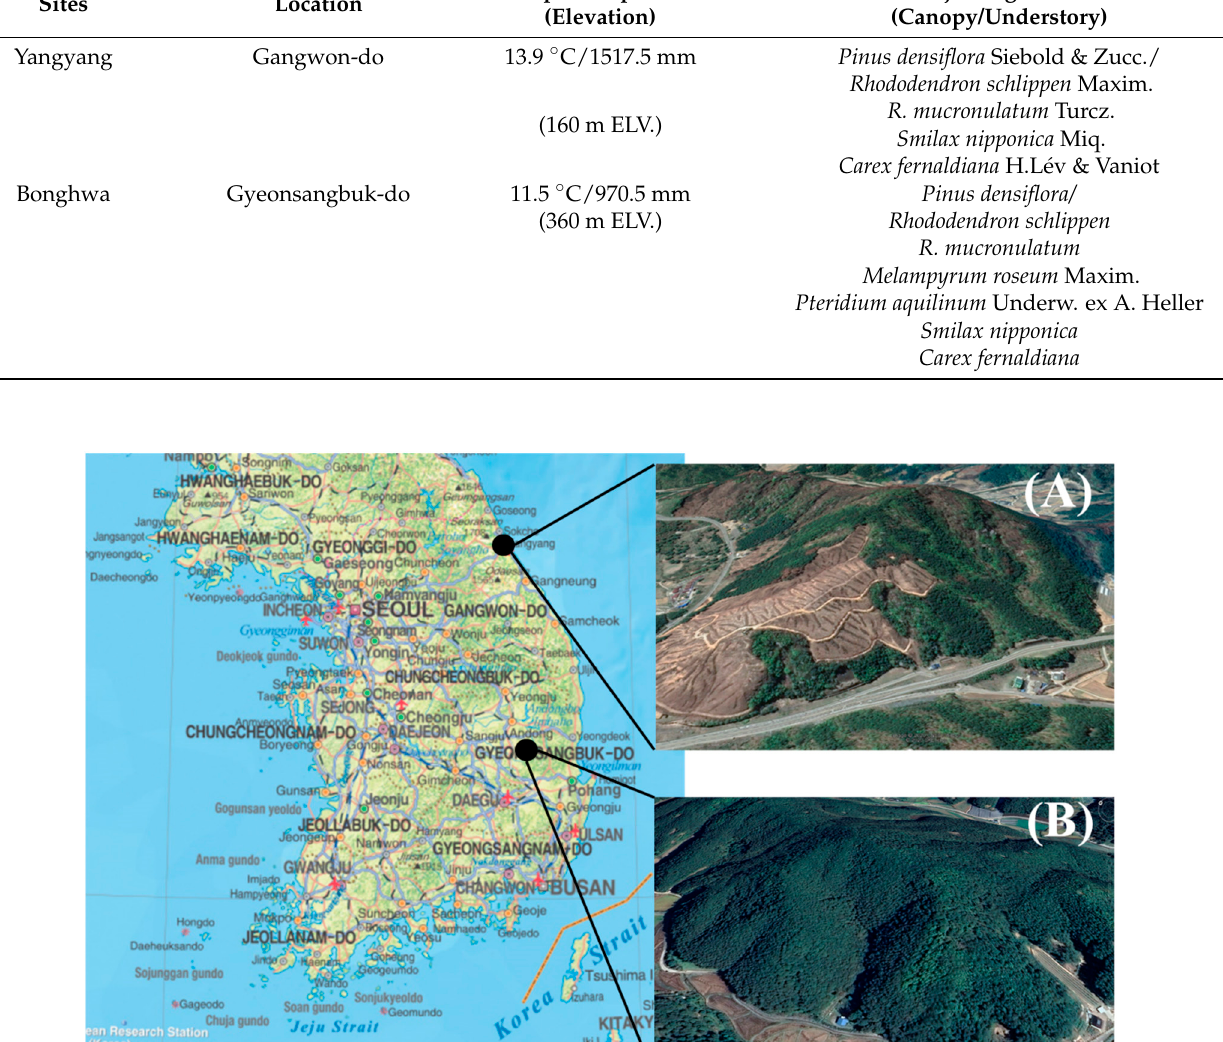
Table 1. Climates and vegetation of the experimental sites (http://www.nongsaro.go.kr/, (accessed on 26 April 2021)). Sites Location